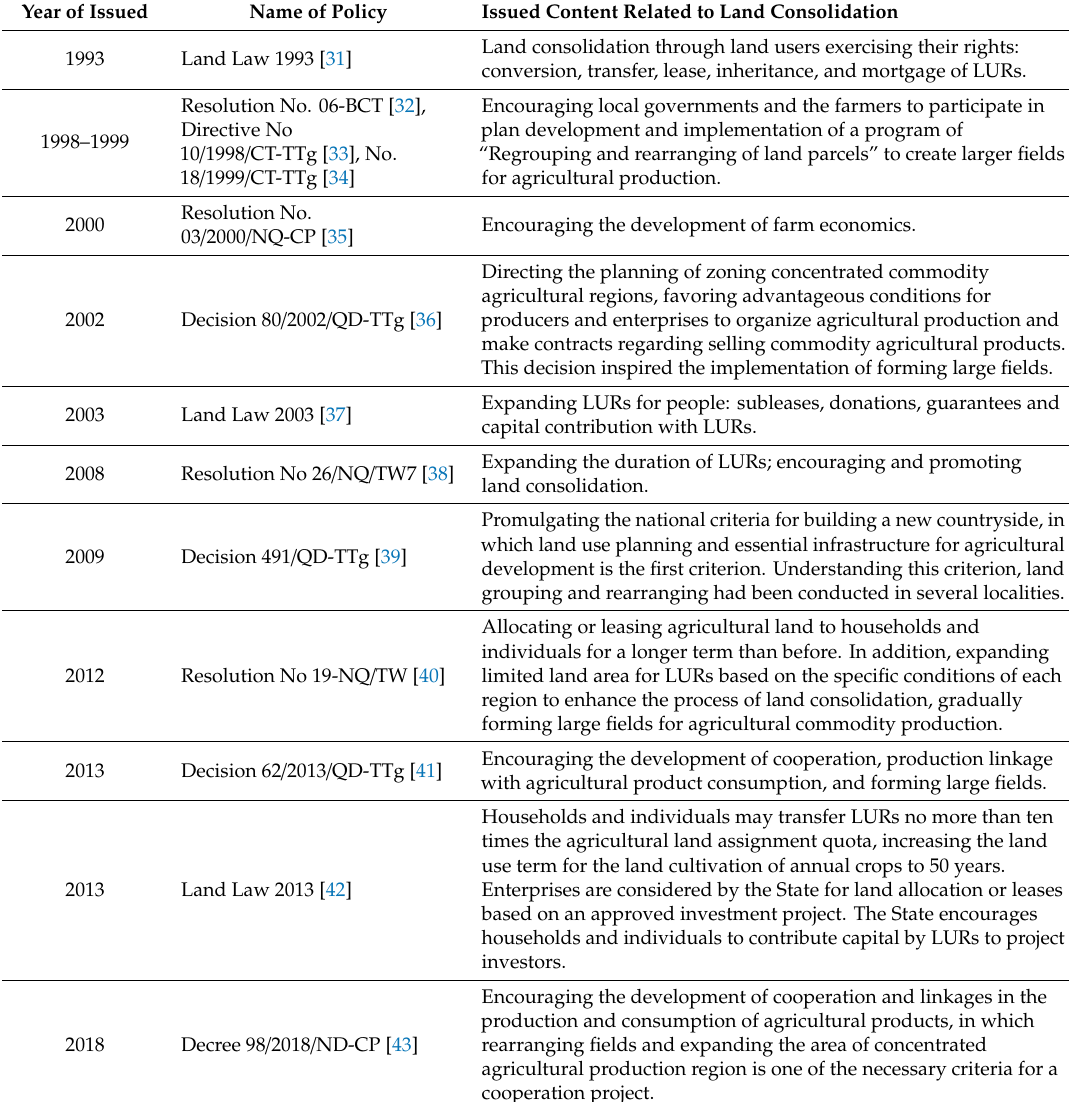
Table 1. Key national policies related to encouraging land consolidation in Vietnam during the Doi Moi